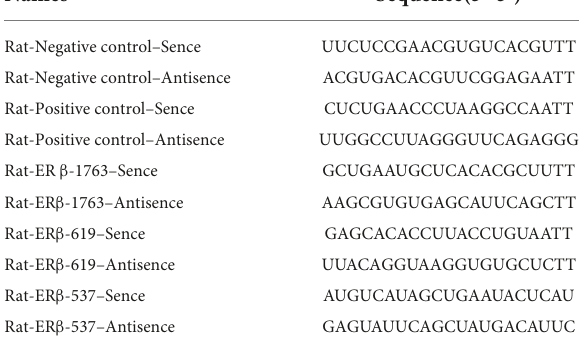
TABLE 1 Sequences of the small interfering RNA (siRNA) involved in this